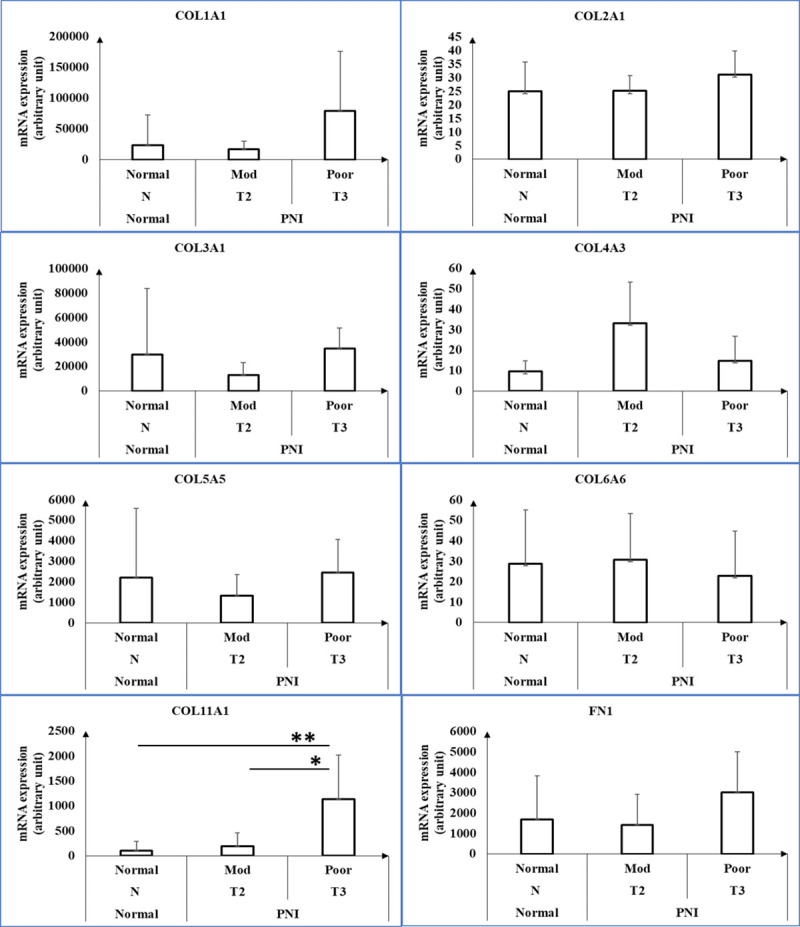
Expression of collagens in normal skin and cSCC tumors with PNI.Collagen and fibronectin mRNA levels in normal skin (n = 7), cSCC tumors with PNI and moderate differentiation (n = 6), and cSCC tumors with PNI and poor differentiation (n = 3) as assessed by Nanostring. Three groups were listed on x-axis based on BWH tumor stage and tumor differentiation. Mod = moderate differentiation; Poor = poor differentiation; N = normal; T2, T3 = BWH tumor stage. * and ** represent p<0.05. COL1A1 = collagen I alpha 1 chain; COL2A1 = collagen II alpha 1 chain; COL3A1 = collagen III alpha 1 chain; COL4A3 = collagen IV alpha 3 chain; COL5A5 = collagen V alpha 5 chain; COL6A6 = collagen VI alpha 6 chain; COL11A1 = collagen XI alpha 1 chain; FN1 = fibronectin.